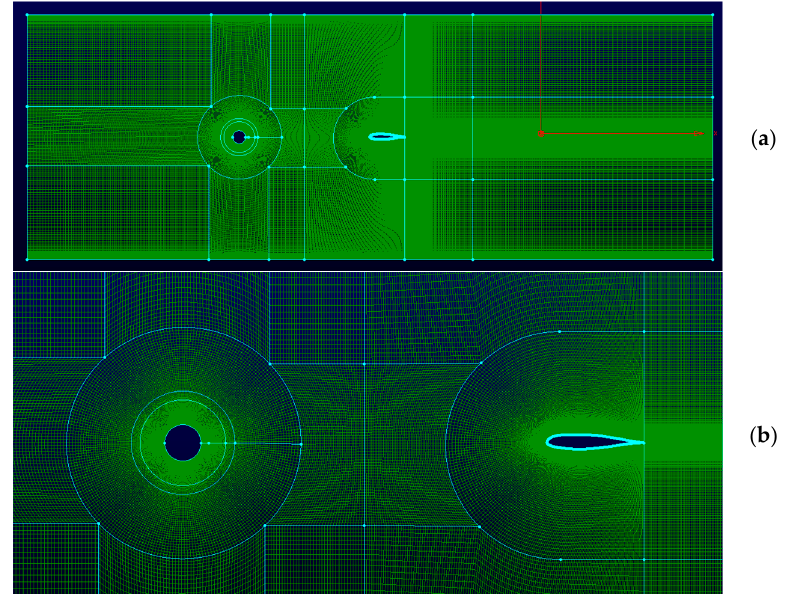
Figure 6. ( a ) Overview of computational domain. ( b ) Zoomed view of the mesh around models.